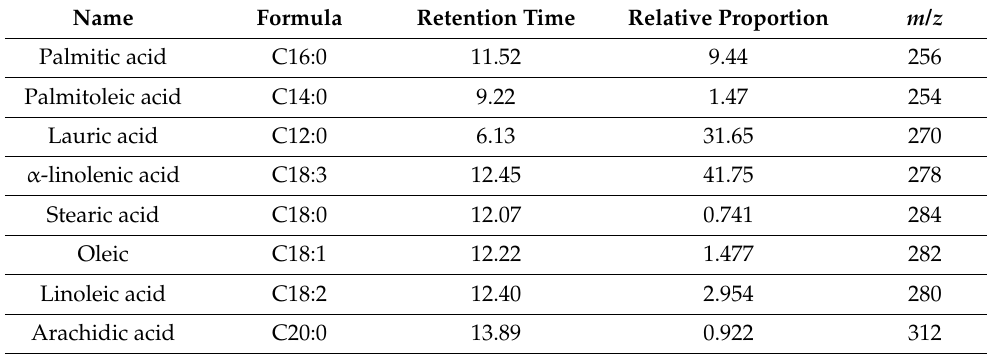
Table 2. Fatty acid profile by the GCMS of triglyceride extracted from leaves.